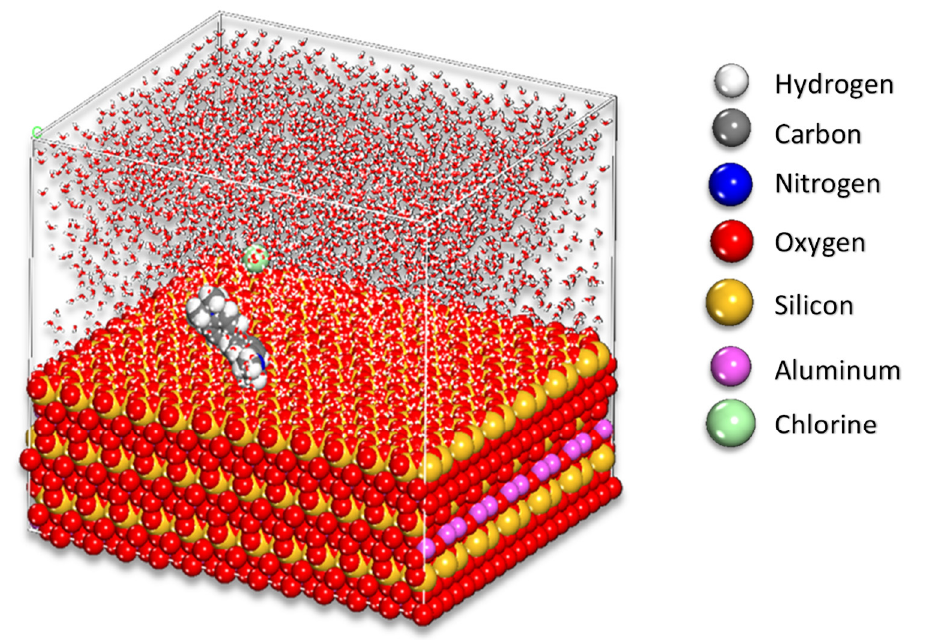
Figure 10. Final MC poses of the lowest adsorption configurations for the MV in the simulated cor- rosion media on the HNC surface PBC model.